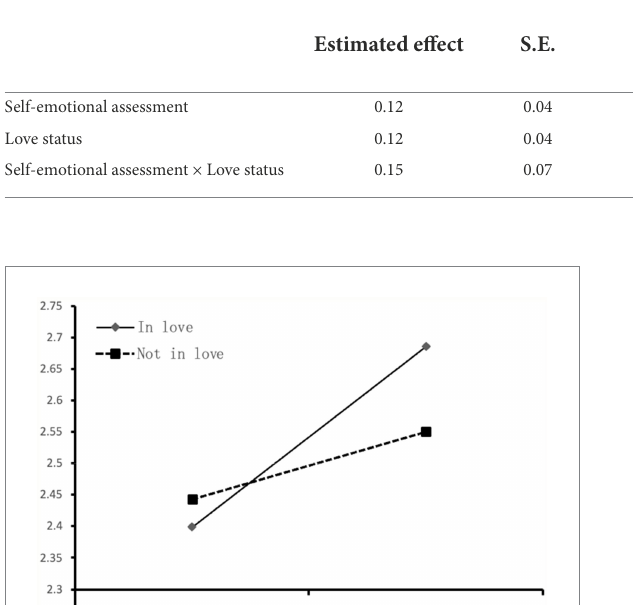
TABLE 6 Statistical analysis